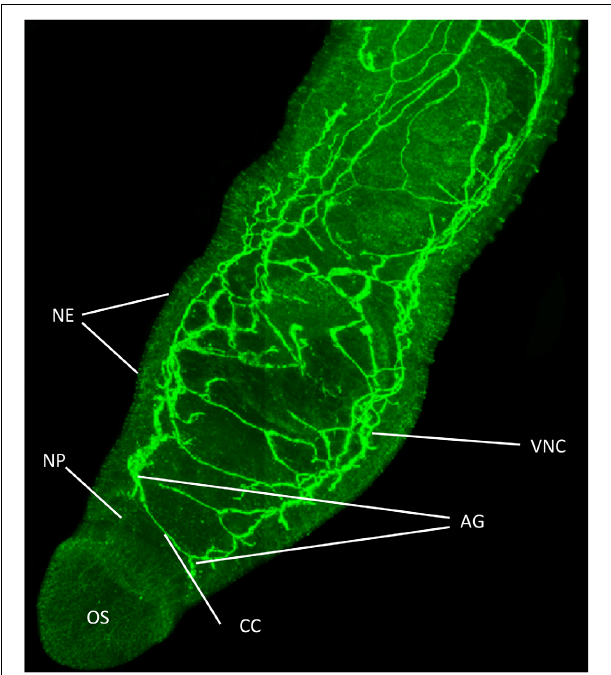
FIGURE 1 | Functional mapping of protein kinase A (PKA) in intact adult S. mansoni . Male worms were fixed immediately after perfusion and stained with anti-phospho antibodies (green) to localize activated PKA. Image shows z-axis projection from intact worm in maximum pixel brightness mode. Intense staining reveals PKA activation particularly associated with the nervous system including in the ventral nerve cords (VNC), connecting cerebral commissures (CC), anterior ganglia (AG), complex nerve plexus (NP) associated with the oral sucker (OS) and nerve endings (NE) at the tegument surface. Bar = 100 μ m. Adapted from De Saram et al.